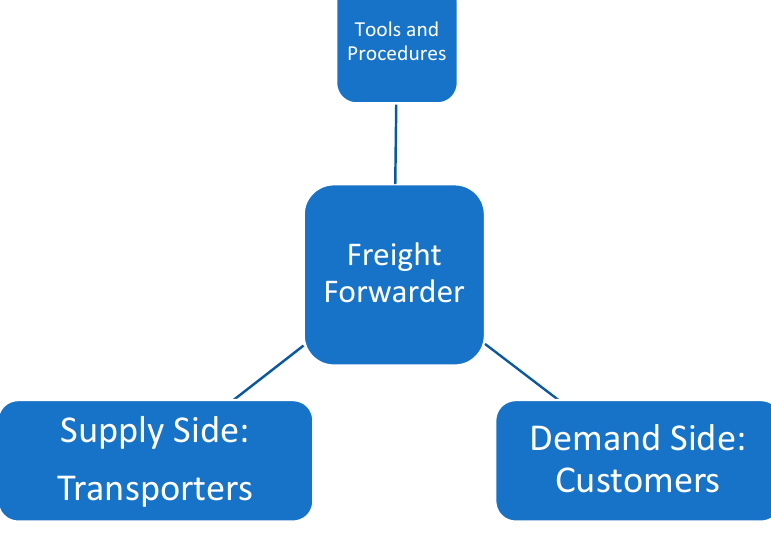
Figure 1. Freight forwarding process.